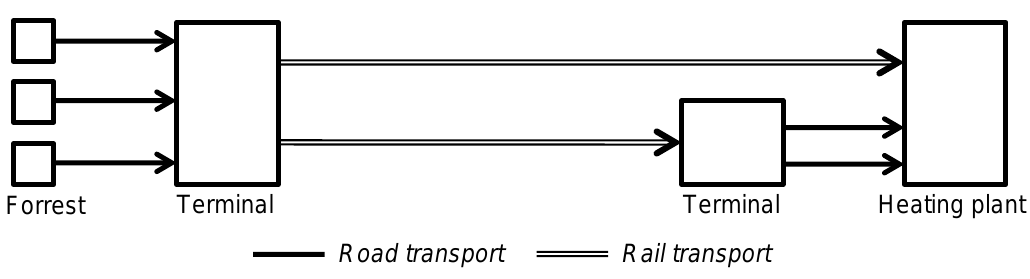
Figure 2. The multimodal transport